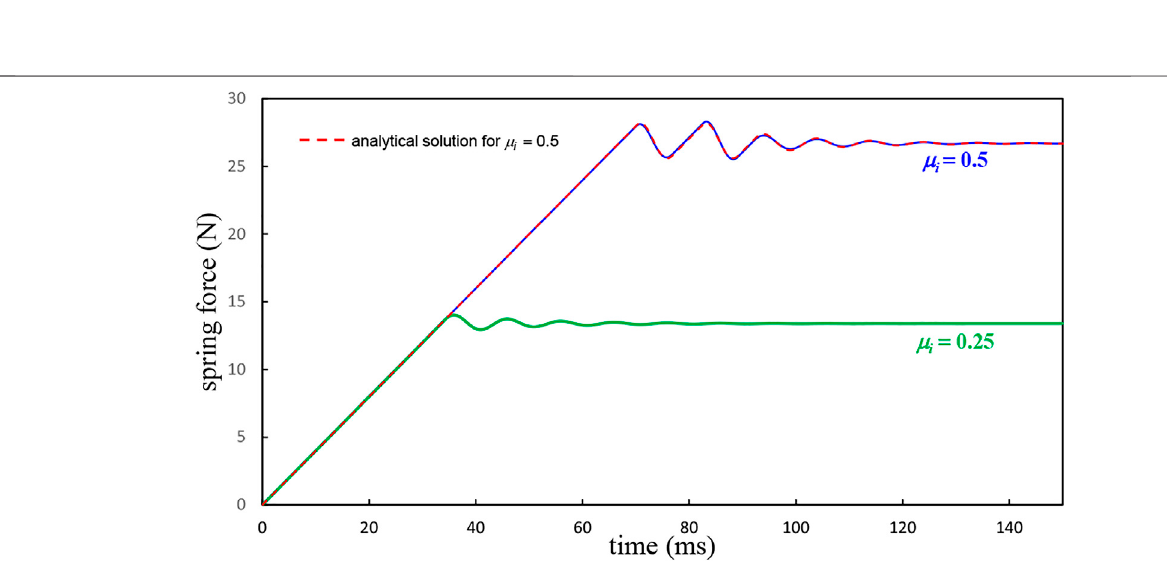
(cid:129) width of slab ( L (cid:2) 1 mm x ) (cid:129) vertical thickness of slab ( L (cid:2) 1 mm z ) (cid:129) depth of slab ( L (cid:2) 1 cm y ) (cid:129) intrinsic coef fi cient of friction ( µ (cid:2) 0.25, or 0.5 i ) (cid:129) radius of curvature of pin tip ( R ) (cid:2) 50 cm or 200 cm (cid:129) normal load ( W ) (cid:2) 100 N (cid:129) elastic constants for slab: G (cid:2) 10 GPa, ] (cid:2) 1/3